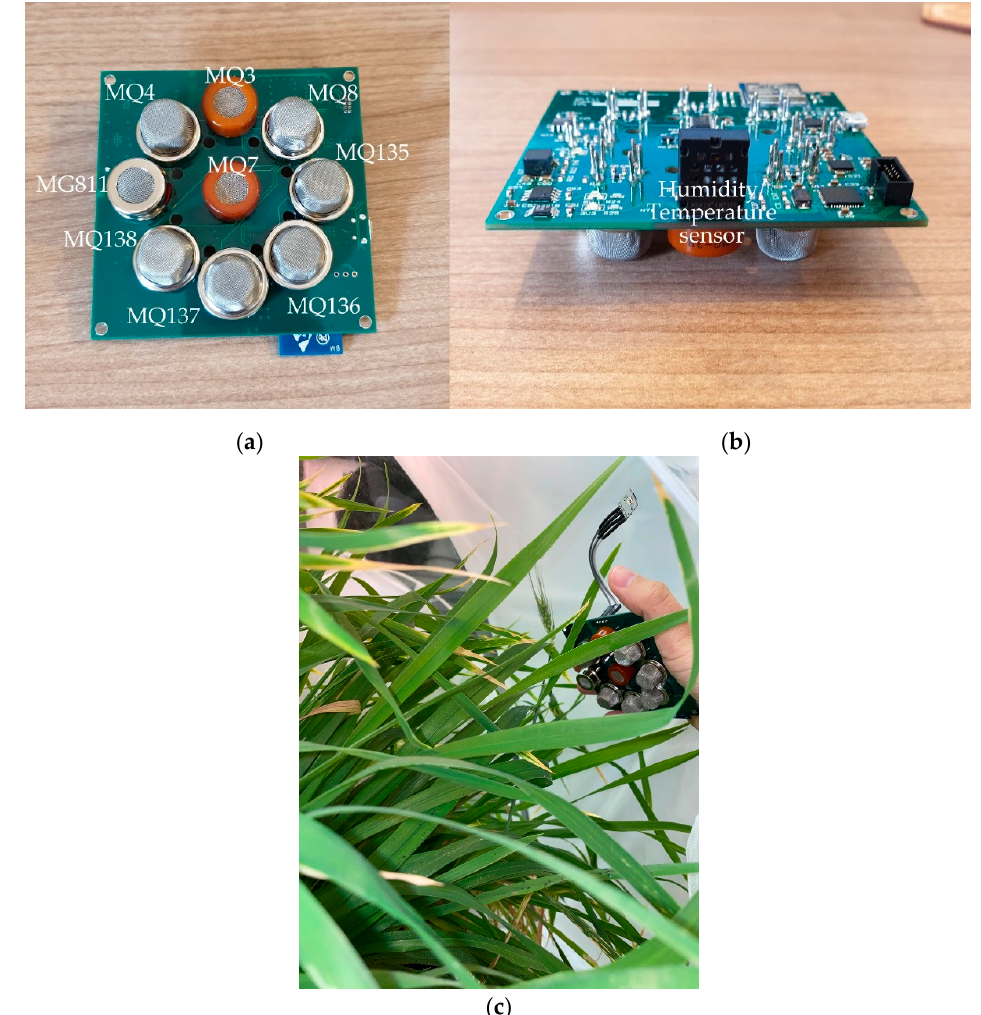
Figure 3. Electronic nose (e-nose) showing ( a ) the front part with gas sensors and their model ID (Henan Hanwei Electronics Co., Ltd., Henan, China) and ( b ) the back part which holds the humidity/temperature sensor; ( c ) Shows the e-nose positioning while taking measurements.